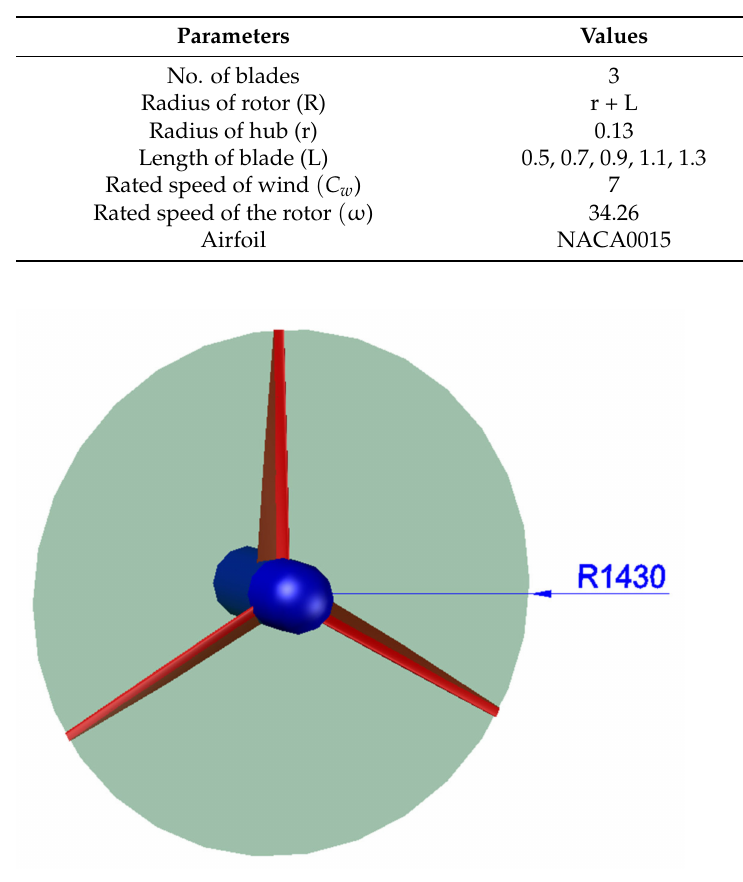
Table 3. Main parameters of optimized horizontal axis wind turbine (HAWT).